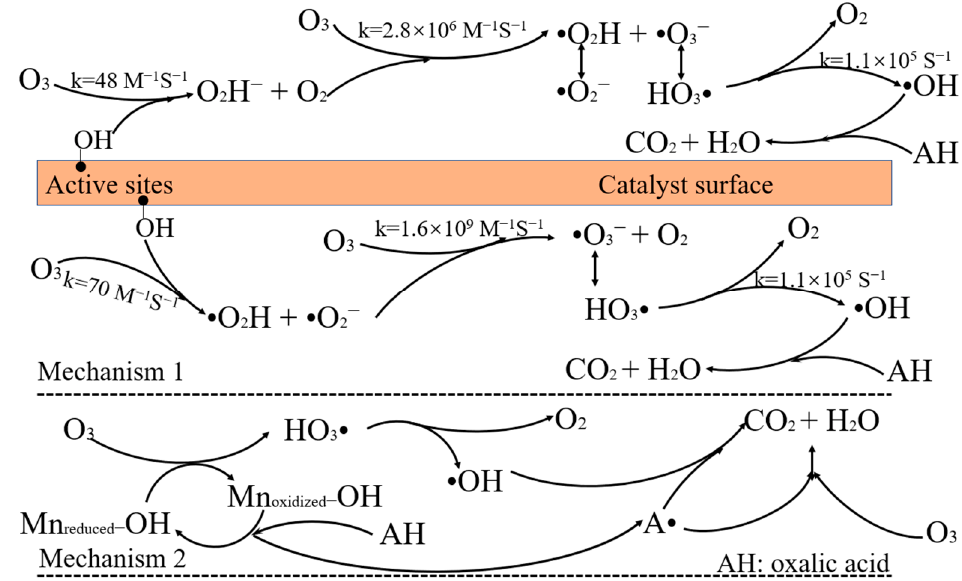
Figure 3. Mechanism of heterogeneous catalytic ozonation with MnO x /SAC (based on [74]).